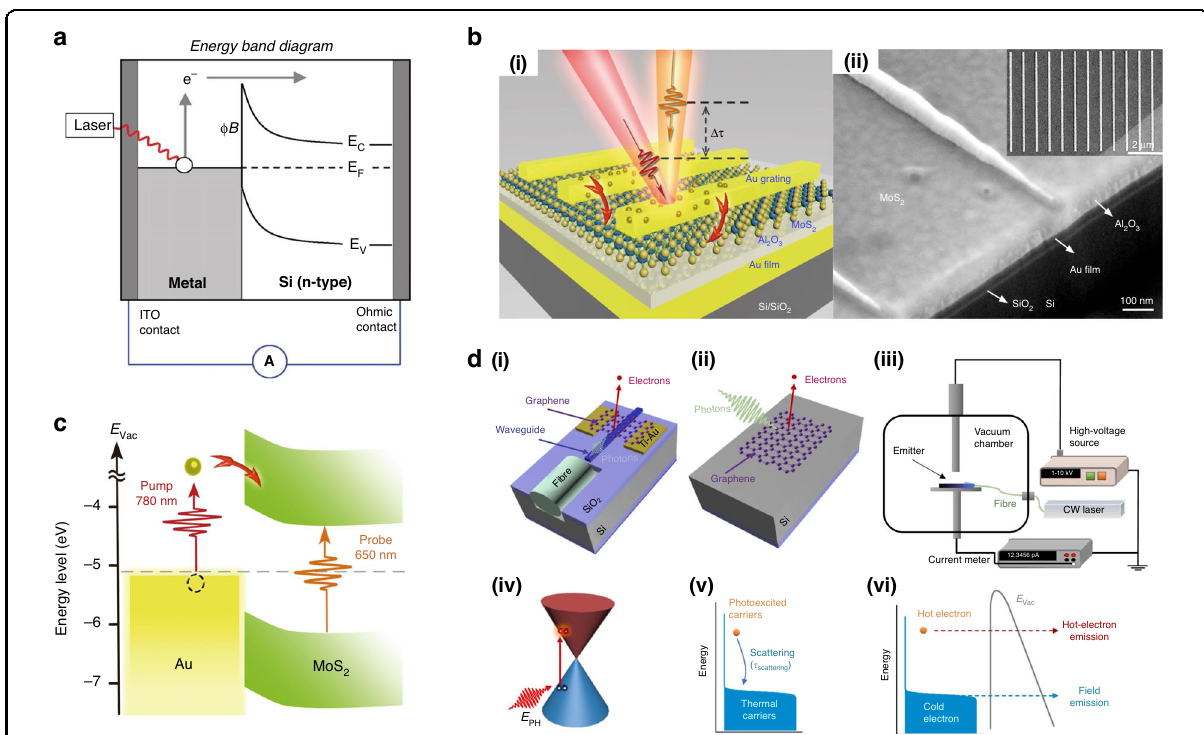
Fig. 21 In plasmonic photodectors various nanostructures (metals and graphene) when embedded in a semiconductor, serve as optical antenna and facilitate the ef fi cient HC generation and transfer to the semiconductor. a The energy band diagram of an optical antenna diode showing the photoexcitation and injection of hot electrons into the Si over the Shottky barrier ( ∅ B ), thus contributing to the photocurrent generation. b – i: The schematic of the sandwiched heterostructure device with an Au grating/MoS 2 /Al 2 O 3 /Au/Si, and b -ii a cross-section image of the MIM structure of a real device. c A diagram showing the band alignment of the Au grating and MoS 2 monolayer where the plasmonic hot electrons were excited by a 780 nm pump laser, and by crossing the Schottky barrier they are injected to MoS 2 monolayer, where the induced variation in the fi lled states is monitored by a 650 nm probe pulse. d The detailed schematics of a complete device model and experimental setup of a graphene photoemitter: (i – iii) the mechanisms of the hot-electron generation and scattering, the hot-electron emission prior to cooling, the fi eld emission of thermal electrons, and (iv – vi) the continuous wave-laser photoemission by the waveguide mechanism of an integrated monolayer of graphene. The fi gures are taken with permission from ( a ) ref. 17 , ( b , c ) ref. 140 , and ( d ) ref.